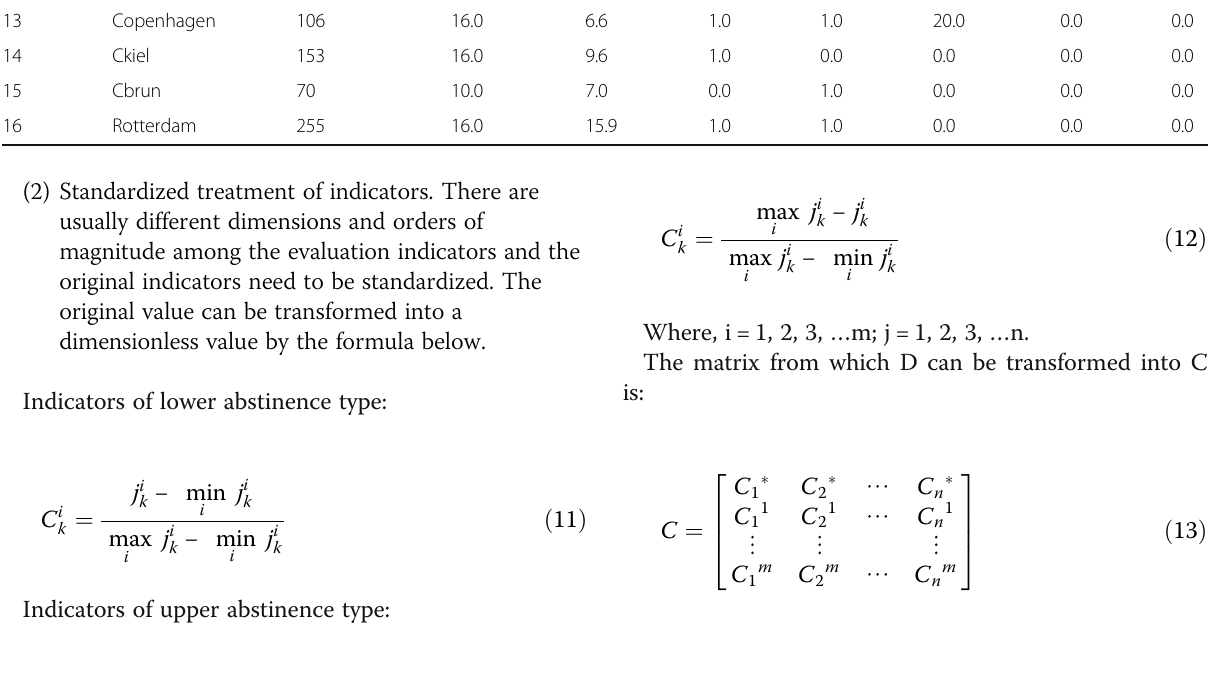
Table 7 Alternatives without Kotka with double hub ports connection (Source: authors) Sea Way Pilot